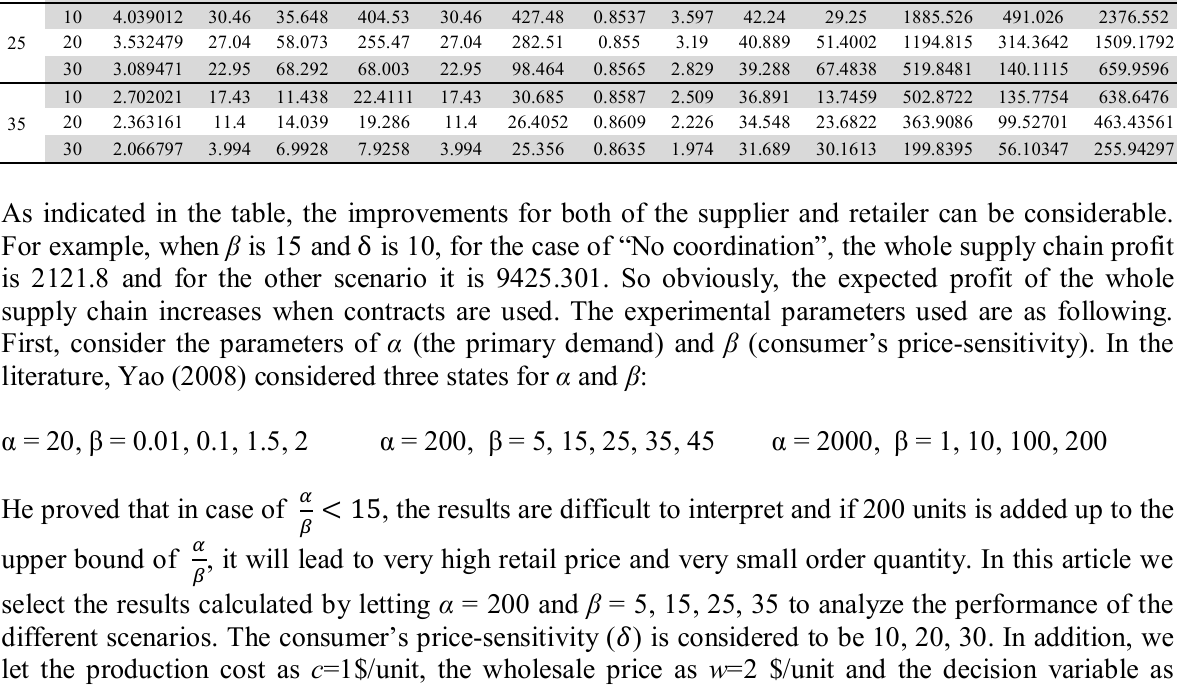
Scenario 1 (No coordination)